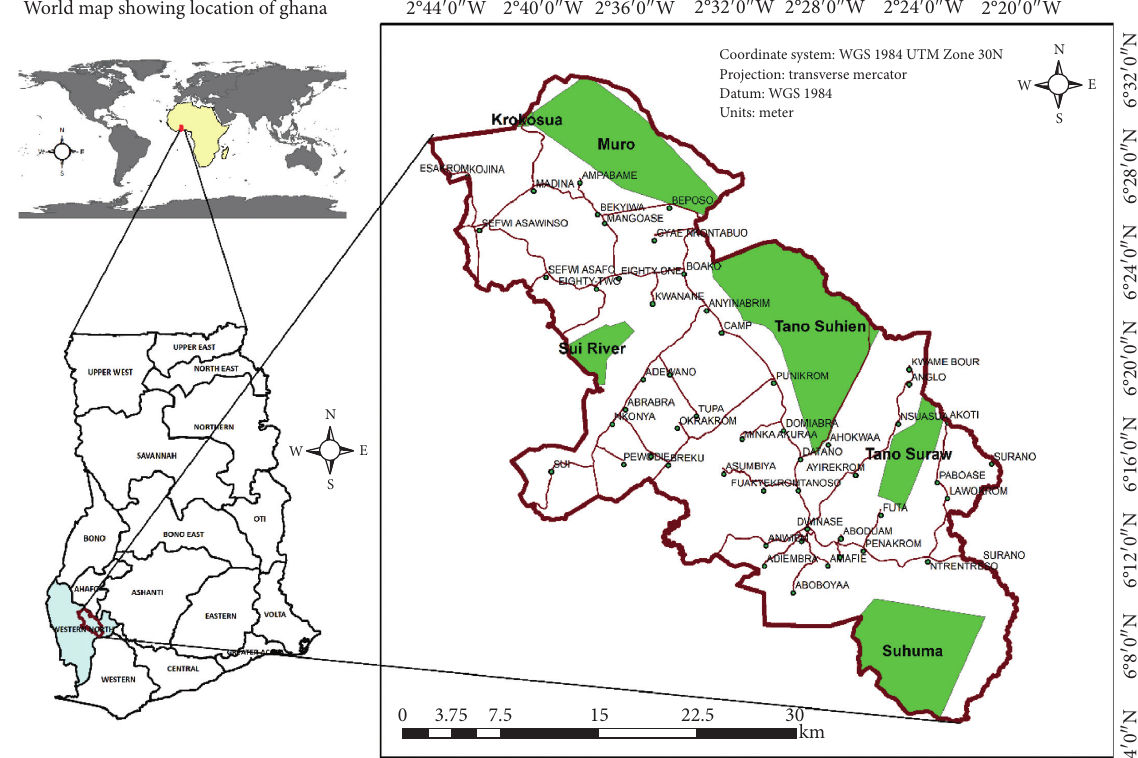
Figure 1: The SWD and the six forest reserves (FRs). Table 1: Areas (ha) and location of FRs within the